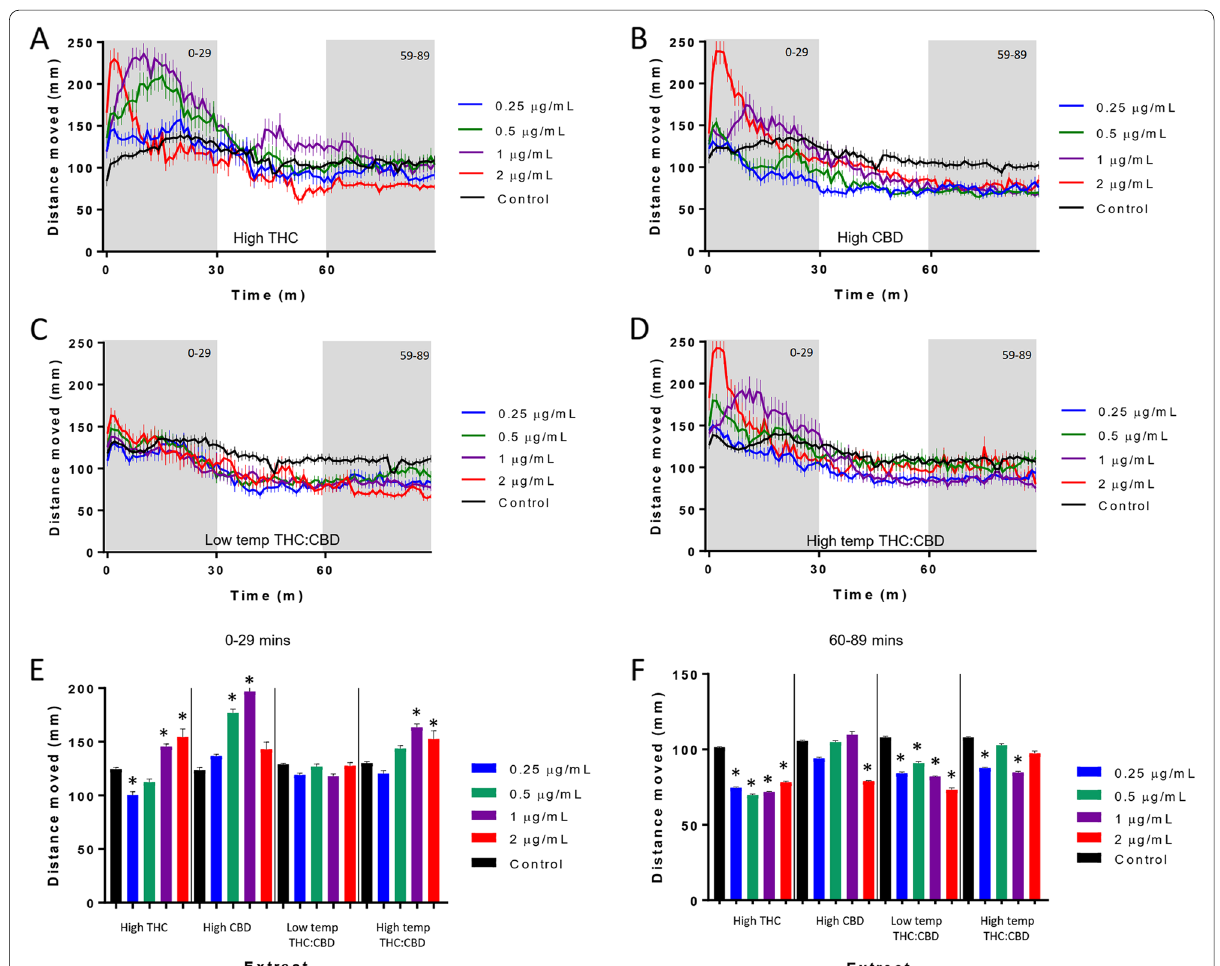
Fig. 1 Larval locomotion following exposure to high THC, high CBD, low‑temp THC:CBD, and high‑temp THC:CBD extracts. A – D Larval behavioral profiles following exposure to extracts at varying concentrations. The average distance traveled is presented in millimeters per 1 min bin error ( SEM ) and time in minutes. E , F The average distance traveled SEM is presented in millimeters per 30 min bin and time in minutes. Each ± bar represents an n 36 (extract) to 96 (control) larvae. *Significant difference from experimental control as measured by ANOVA followed by a = Bonferroni post hoc test ( p <